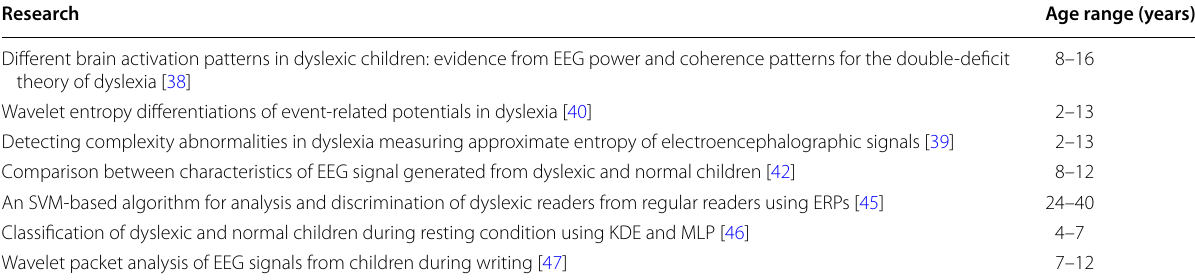
Table 5 Determination of age range Research